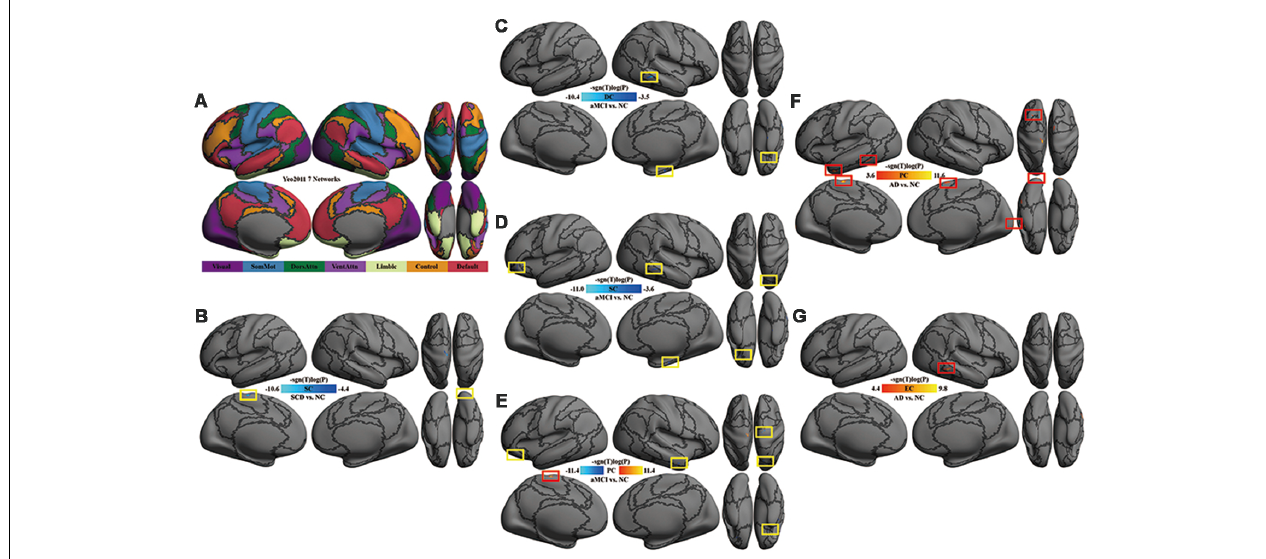
FIGURE 1 | Multi-scale network centrality changes in AD progression. (A) The seven networks map in Yeo et al. (2011). (B) SC in SCD vs. NC. The reduced SC in SCD was located in the left somatomotor network (left paracentral cortex) and the right visual network (right occipital cortex). (C) DC in aMCI vs. NC. The reduced DC in aMCI were located in the right default network (orbital gyri), the right limbic network (parahippocampal areas) and the right frontoparietal control network (middle temporal area). (D) SC in aMCI vs. NC. Except for the default, limbic and frontoparietal control network, the reduced SC in aMCI extended to the left default network (orbital cortex) and the right dorsal attention network (superior parietal areas). (E) PC in aMCI vs. NC. Significant decreases of PC in aMCI were observed within the default network (right middle temporal and bilateral orbital gyrus), the right somatomotor network (precentral area), the right dorsal attention network (superior parietal area) and the left limbic network (orbital areas), whereas significant increases of PC in aMCI were detectable within the left somatomotor network (paracentral area). (F) PC in AD vs. NC. The increased PC in AD were located in the visual network (occipital areas), the left somatomotor network (paracentral area), the left limbic network (temporal pole), the left dorsal attention network (inferior temporal area), the left default network (superior frontal gyrus) and the right ventral attention network (superior frontal area). (G) EC in AD vs. NC. A significant increase of EC was found in the right frontoparietal control network (inferior temporal sulcus). All the above tests were thresholded at an false discovery rate (FDR) corrected significance level of p < 0.05. Gray curves indicate the boundaries according to the seven networks map in Yeo et al. (2011). Abbreviations: NC = normal control; SCD = subjective cognitive decline; aMCI = amnestic mild cognitive impairment; AD = Alzheimer’s disease; DC = degree centrality; SC = subgraph centrality; PC = page-rank centrality; EC = eigenvector